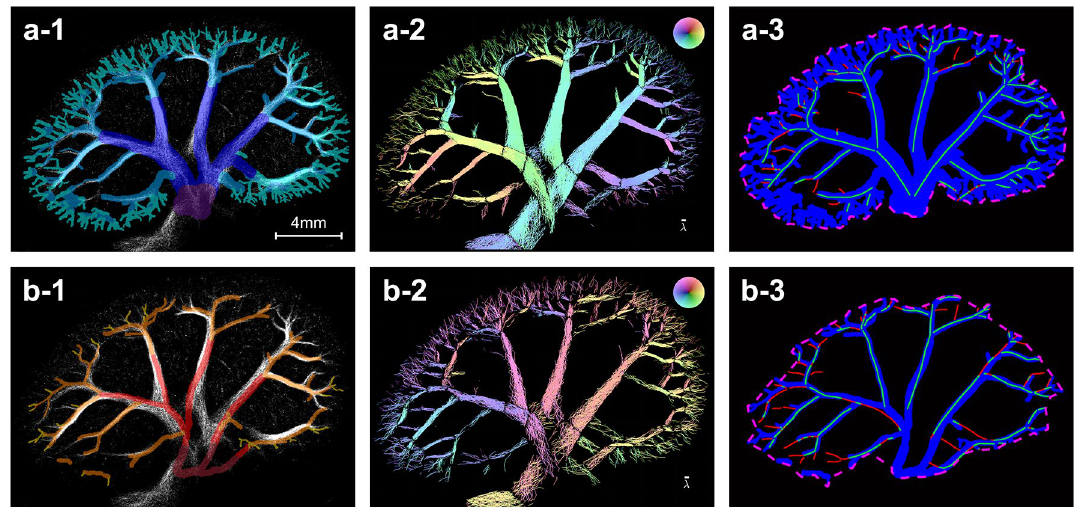
Figure 3. Vessel overlap estimation. ( a ) Veins, ( b ) Arteries. ( a-1 , b-1 ) Manually drawn veins and arteries on the μ CT in the super-resolution ultrasound scan 2 overlap (the colored μ CT segmentation is displayed on top of a white super-resolution ultrasound image). Purple = renal vein branches, dark blue = segmental veins, blue = arcuate veins, turquoise = cortical radial veins, dark red = renal artery branches, red = segmental arteries, orange = arcuate arteries, yellow = cortical radial arteries. ( a-2,b-2 ) Filtered microbubble track maps including only regions labeled as “segmental or larger arcuate vessels” or “cortex” and separated into a map with only vein ( a-2 ) and only artery ( b-2 ) tracks, respectively. ( a-3 , b-3 ) Overlap of the manually drawn vessel centerlines in the super-resolution image (green and red lines) and μ CT vessel ROIs (blue) inside the μ CT ROI region (pink dashed line). The green centerlines are overlapping the μ CT ROIs while the red centerlines are